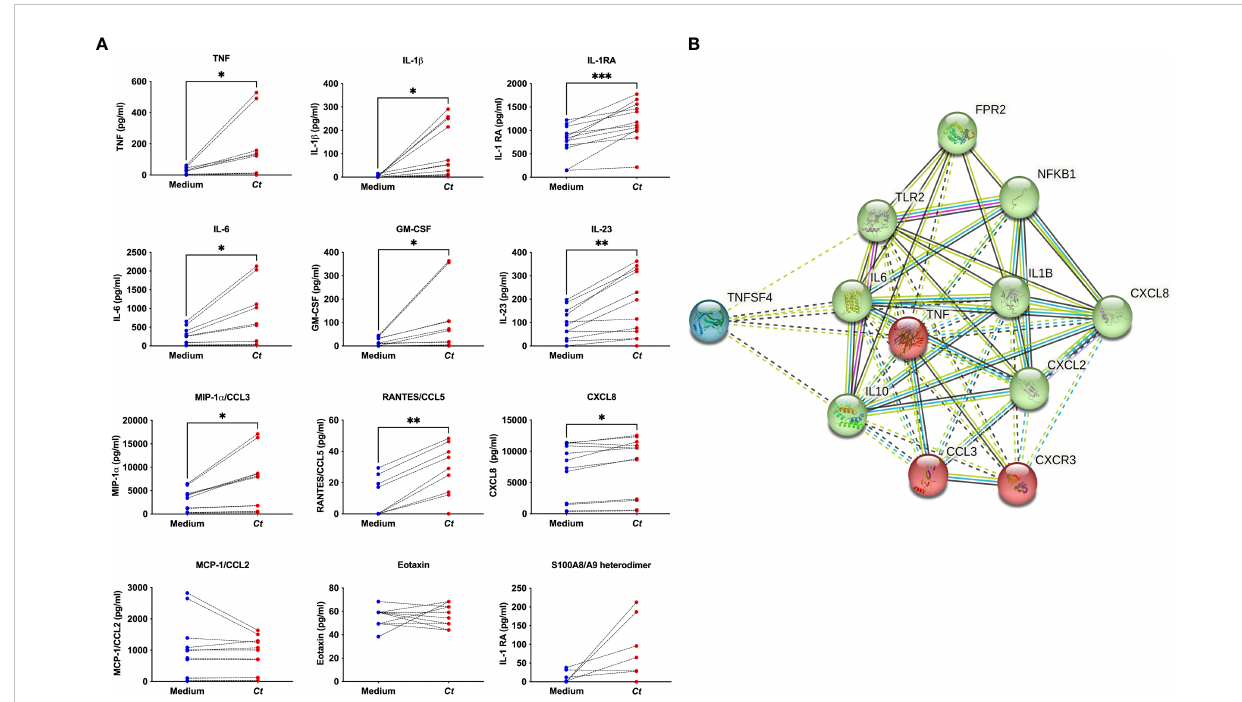
FIGURE 4 C. trachomatis -treated mast cells produced several mediators. Supernatants from CBMCs treated with C trachomatis MOI = 1 or paired medium controls were analyzed for the presence of 29 cytokines and chemokines by a multiplex assay. S100A8/A9 heterodimer protein was measured by ELISA (A) . Data represent n = 6 to 10 donors from three independent experiments. Data are graphed as the mean ± SEM. * p < 0.05, ** p < 0.01, and *** p < 0.001, as determined by a nonparametric Wilcoxon signed-rank test. An interactome analysis was generated on the STRING database of selected mediators following C trachomatis treatment and shows three clusters grouped by green, red, and blue nodes with an average local clustering coef fi cient = 0.893 (B) Edges between the nodes represent protein-to-protein associations indicating known interactions (from curated databases or experimentally determined) or predicted interactions (from gene neighborhood, gene fusions, and co-occurrence) or other predictions through text mining, co-expression, and protein